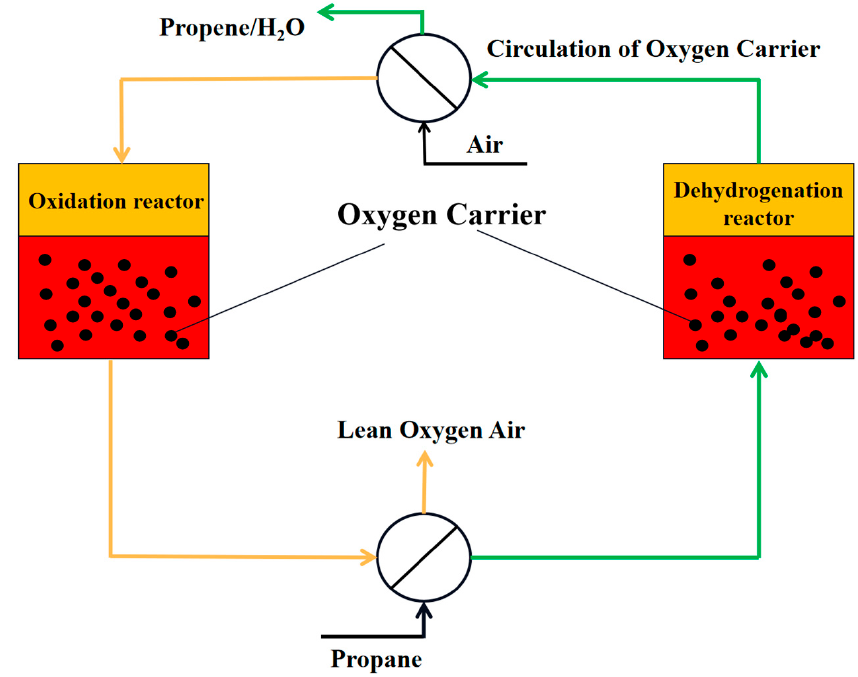
Figure 4. The process fl ow diagram of chemical looping oxidative dehydrogenation.